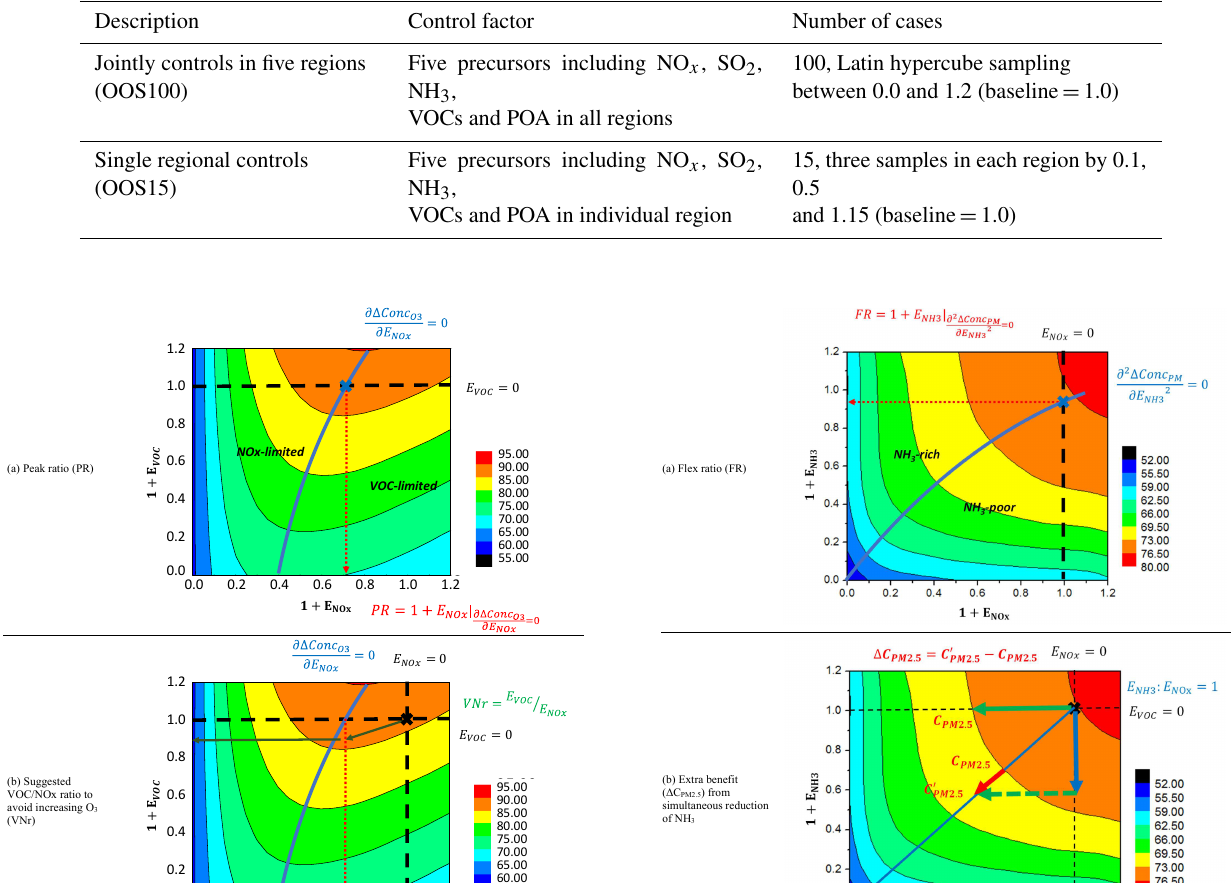
100, Latin hypercube sampling between 0.0 and 1.2 (baseline = 1.0) 15, three samples in each region by 0.1, 0.5 and 1.15 (baseline = 1.0)